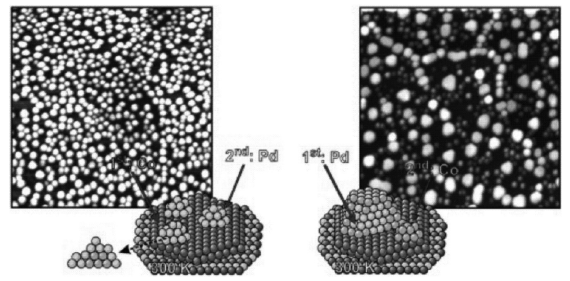
Fig. 17 – STM images (100 nm × 100 nm) taken after depositing 2Å Pdand2Å Coalone. Theballmodelsschematicallyshowthestructure of the systems investigated: gray: NiAl substrate; blue: Al 2 O 3 film; light blue: defects of the alumina film; yellow: Pd atoms; orange: Co atoms (Heemeier et al. 2002).